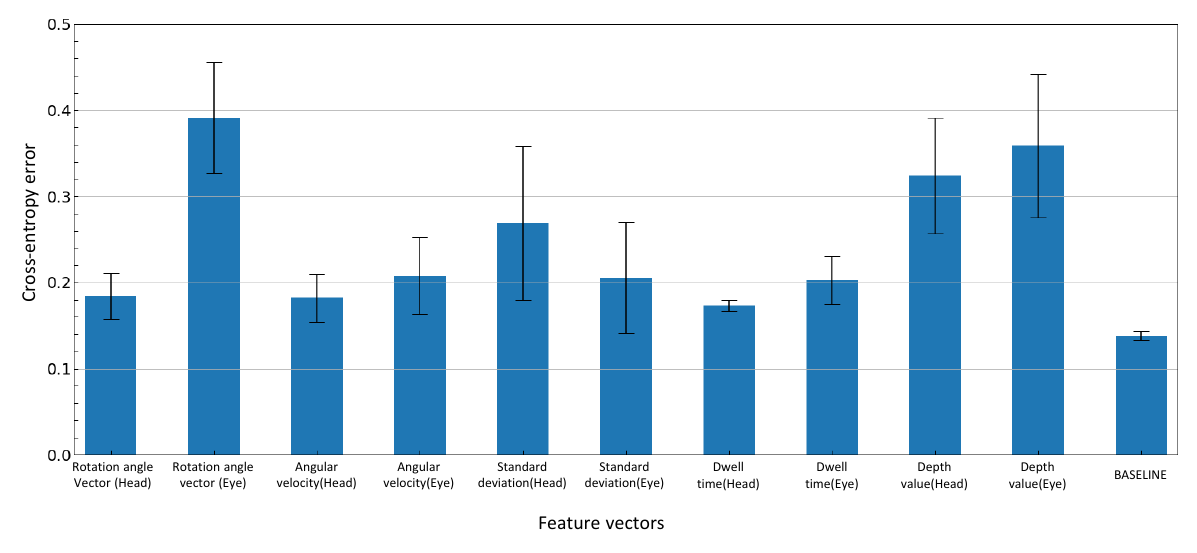
Figure 10. Result of permutation feature